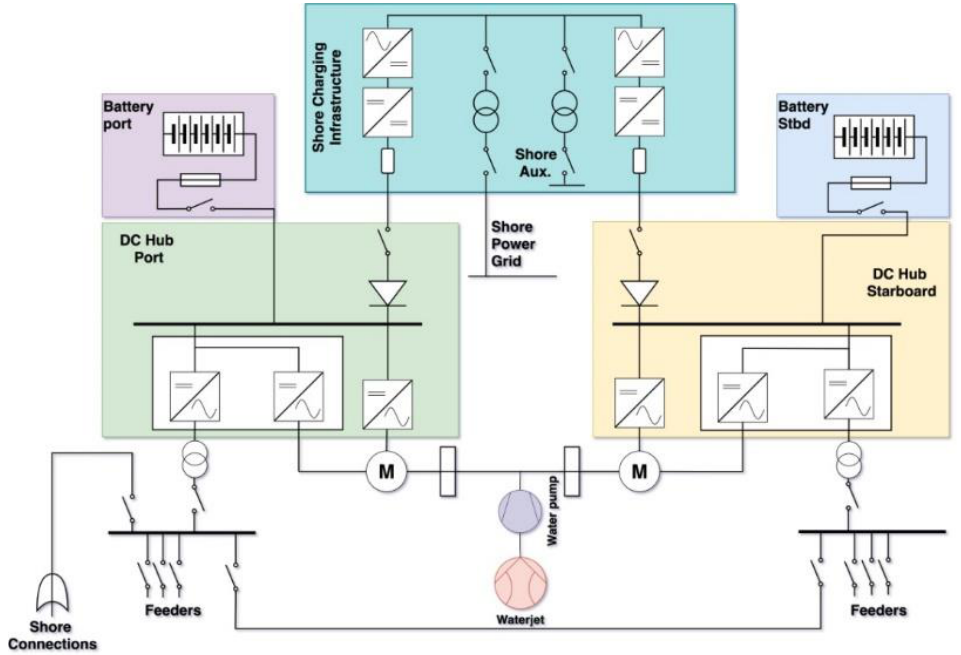
Figure 3. Battery power system.